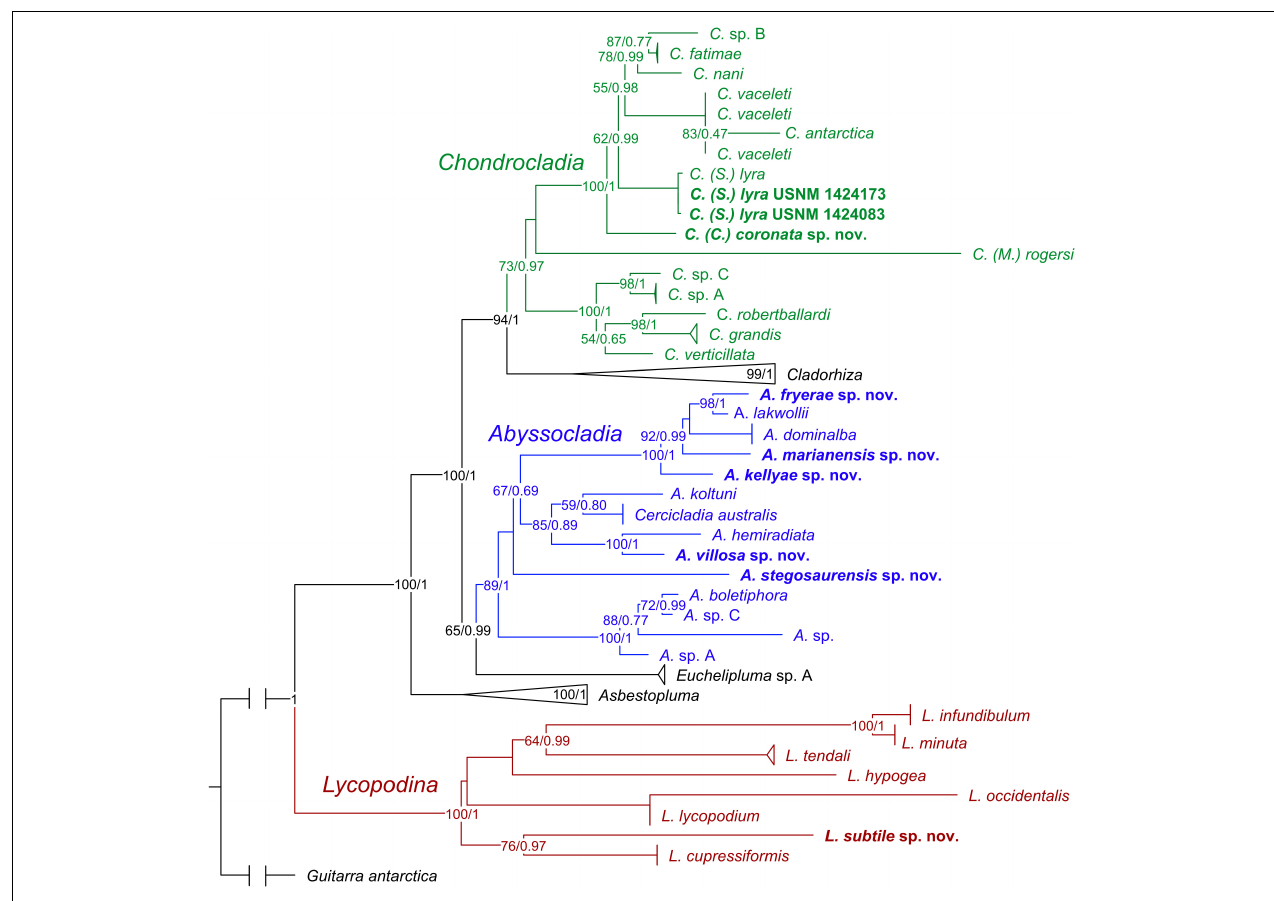
FIGURE 11 | ML consensus tree of a concatenated phylogeny of the Cladorhizidae based on partial 28S rRNA, COI, and ALG11. The analysis includes available cladorhizid sequences from GenBank as well as an outgroup taxon ( Guitarra antarctica ). Sequences for specimens described in this article are indicated in bold. Bayesian posterior probabilities (0–1) and ML bootstrap values (1–100) are indicated for nodes that were recovered in both analyses. Genera including species described in this article are color coded green for Chondrocladia , blue for Abyssocladia , and red for Lycopodina . The genera Cladorhiza and Asbestopluma and species with sequences from several specimens have been collapsed to aid